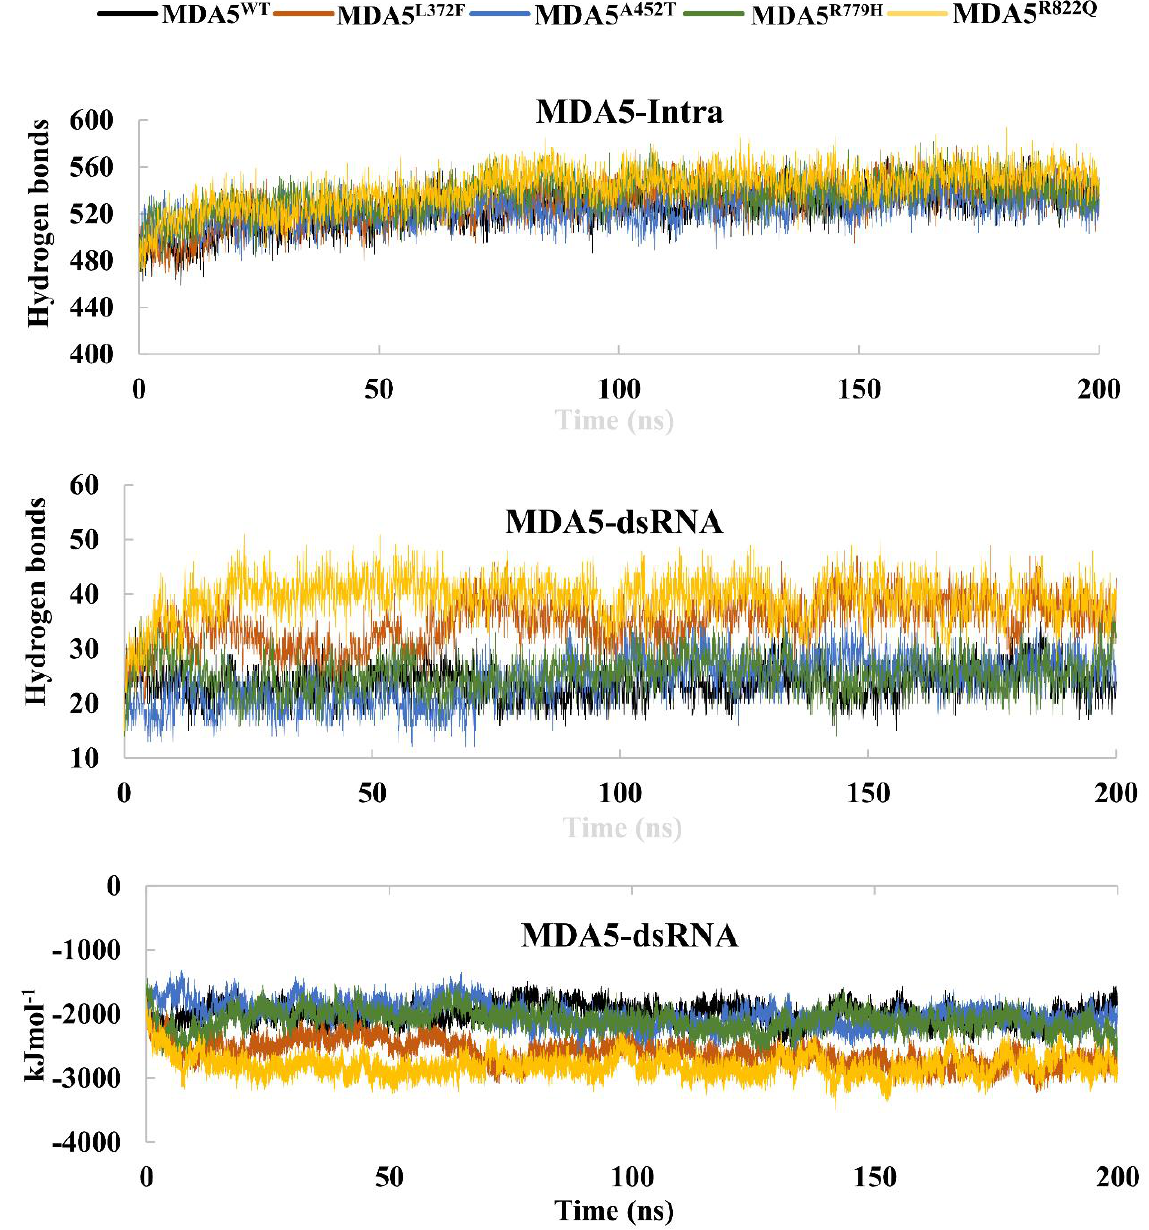
Figure 3. Hydrogen bonds and interaction energies of the molecular dynamics trajectories . Table 1. Summary of trajectory analysis results of MDA5 WT , MDA5 L372F , MDA5 A452T , MDA5 R779H , and MDA5 R822Q simulations. Standard deviations are given in the brackets.